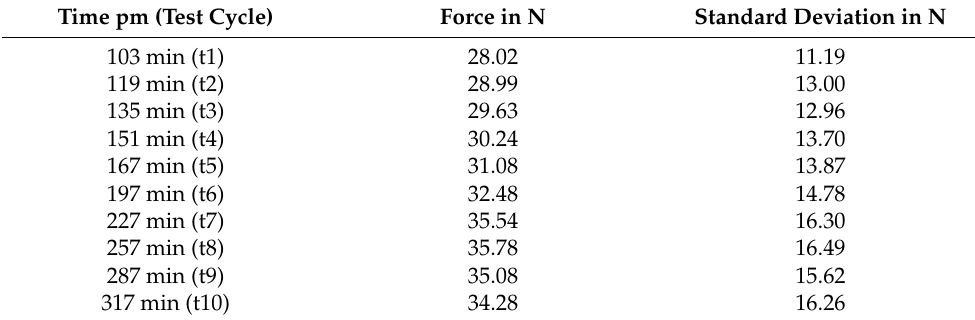
Table 1. Measured force per test cycle.